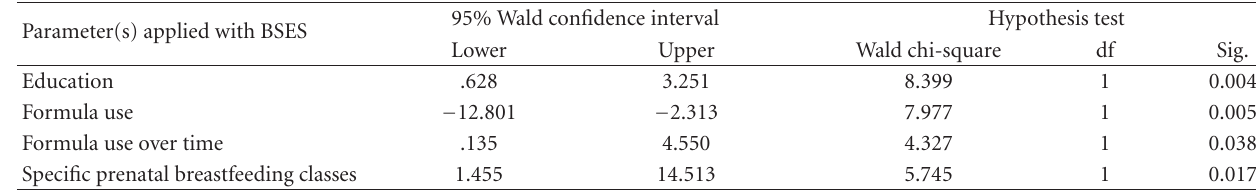
Table 4: Parameter results for predicting BSES and independent